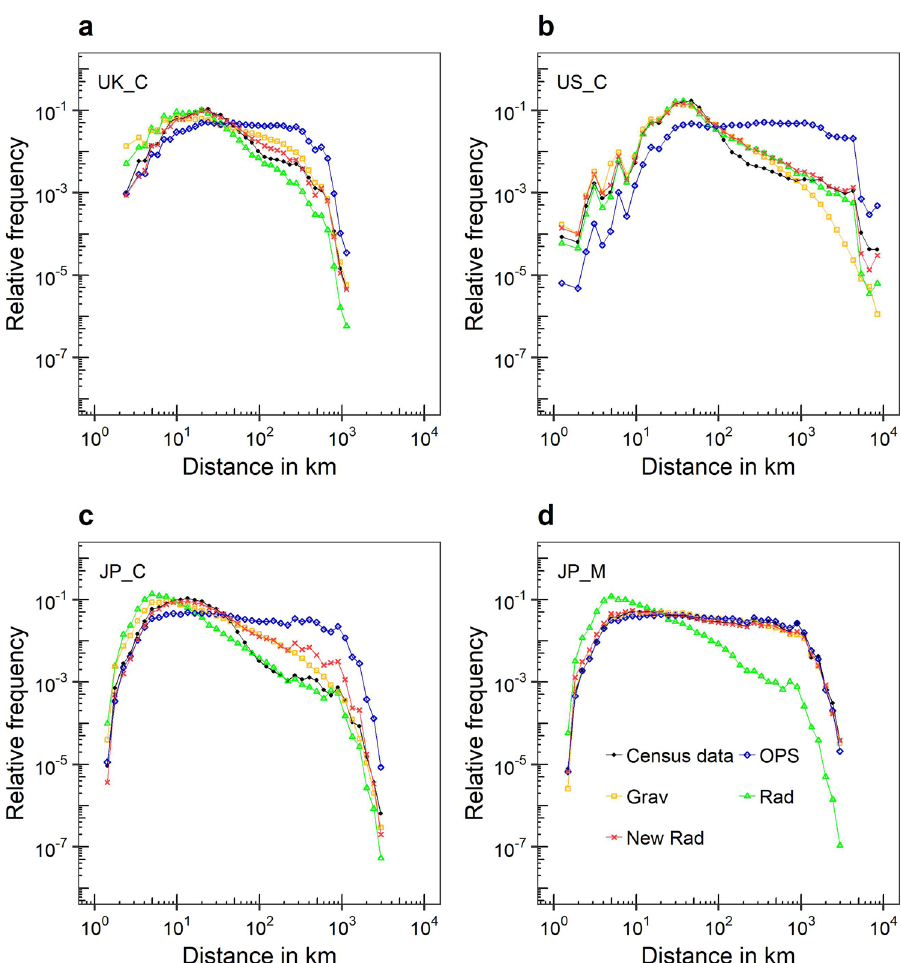
Figure 7. Relative frequency of trip size distribution by distances for census-based observations and model predictions by datasets: ( a ) UK_C. ( b ) US_C. ( c ) JP_C. ( d ) JP_M. Grav, New Rad, OPS, and Rad indicate